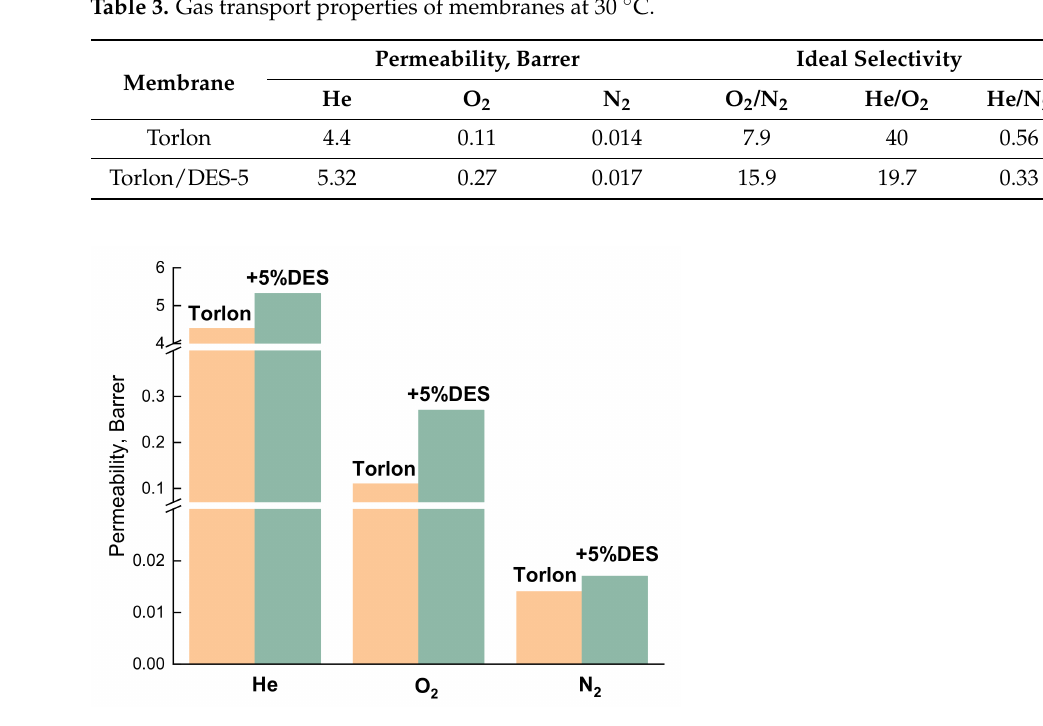
Figure 10. Permeability of Torlon and Torlon/DES-5 composites for He, N 2 , and O 2 at 30 ◦ C.